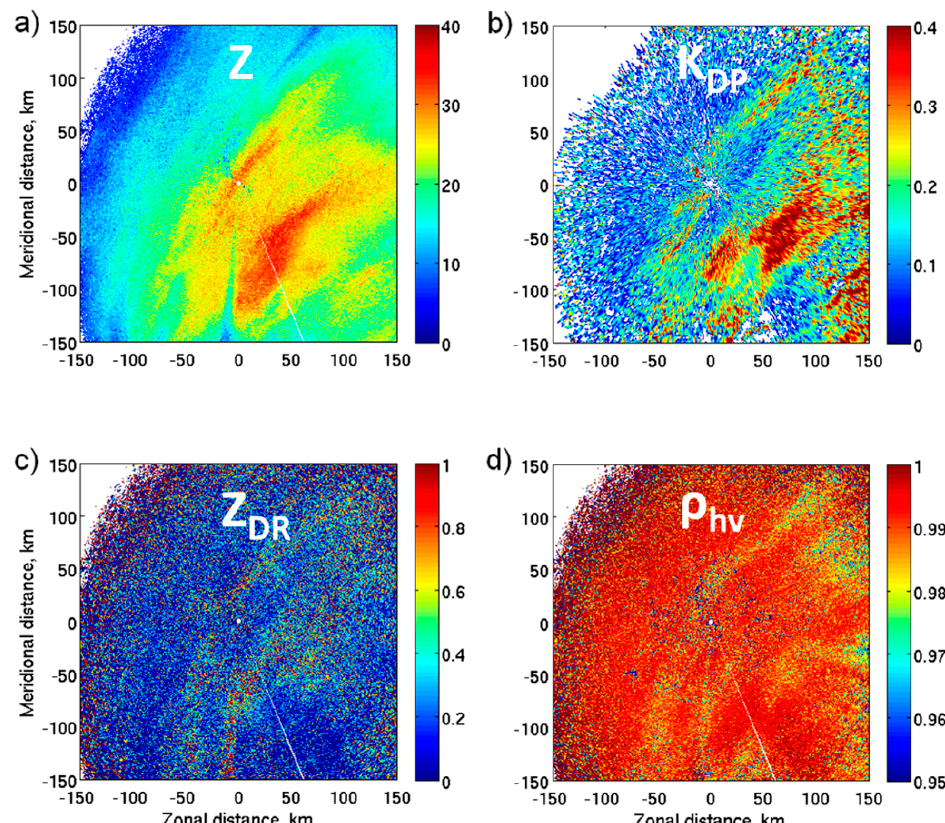
Figure 16. Composite PPI of ( a ) Z , ( b ) K DP , ( c ) Z DR , and ( d ) ρ hv at El = 0.5 ◦ measured by the KBGM WSR-88D radar in the Stella snowstorm on 14 March 2017 at 1256